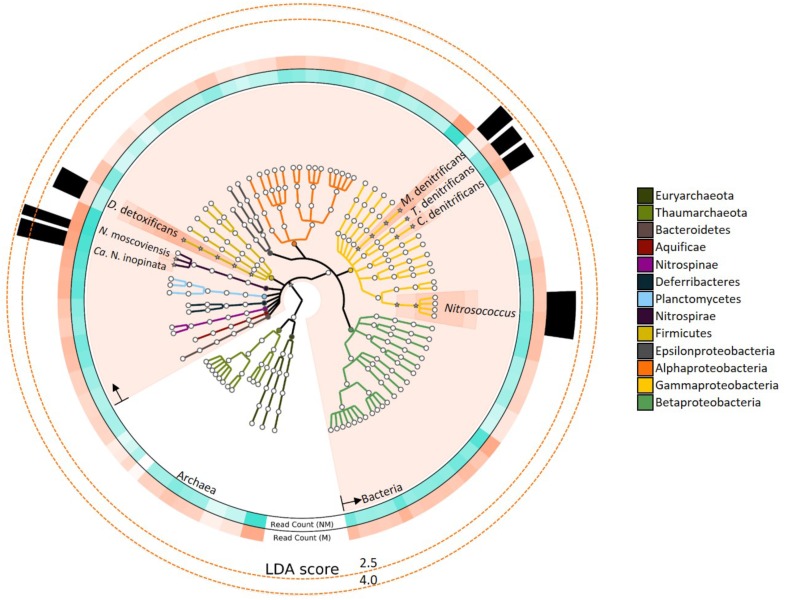
Nitrogen-cycling taxonomies assessed for linear discriminant analysis (LDA) effect size are colored based on phylum, as specified in the legend. Taxons shown with a “∗” icon and salmon-colored background had statistically significant LDA scores (LDA > 2, P < 0.05). Rings surrounding the phylogenetic tree depict the relative abundance of reads assigned to the respective species. Ring color intensity represents relative read count with mussels (salmon-colored; “M”) and with no mussels (turquoise-colored; “NM”). The opacity of “Read count” ring-segments corresponds to the greatest taxonomic abundance. Several N-cycling taxons were differentially abundant with mussels and LDA effect sizes are represented by the height of black bars in the outer-most ring.